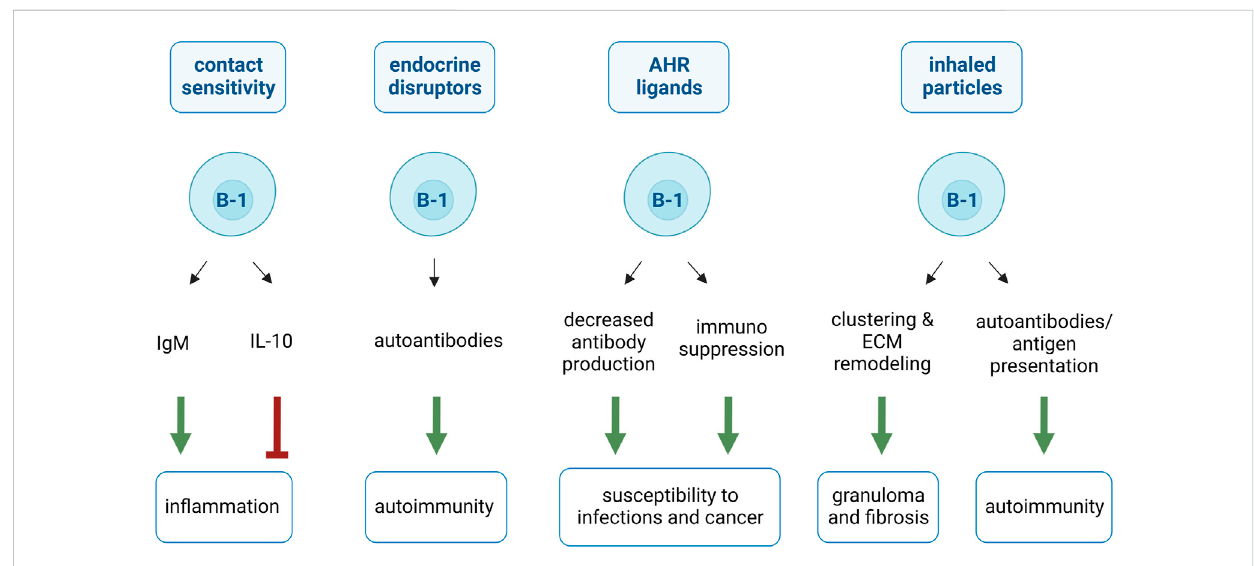
FIGURE 3 Proposed effects of B-1 cells in response to chemicals and particles. B-1 cells sense chemicals and particles and amplify (green arrows) or dampen (red arrow) associated diseases. B-1 cells are activated by contact sensitivity-inducing haptens, produce IgM and promote in fl ammatory pathology. B-1 cellsalsolimitin fl ammatoryresponsesbyreleasinganti-in fl ammatorycytokines(IL-10).B-1cellspromoteautoimmunitybysensingendocrinedisruptors andincreasingtheir autoantibodyproduction.AHRligands reduce B-1cell ability tosecreteantibodies but favortheirimmunosuppressive activities. These two effects explain susceptibility to infection and cancer associated to AHR ligands. B-1 cells mediate inhaled particle-induced granuloma formationand fi brosisbyclusteringcellsandparticlesandremodelingextracellularmatrix(ECM).B-1cellsarealso implicatedininhaled particle-induced autoimmune diseases by secreting autoantibodies and presenting